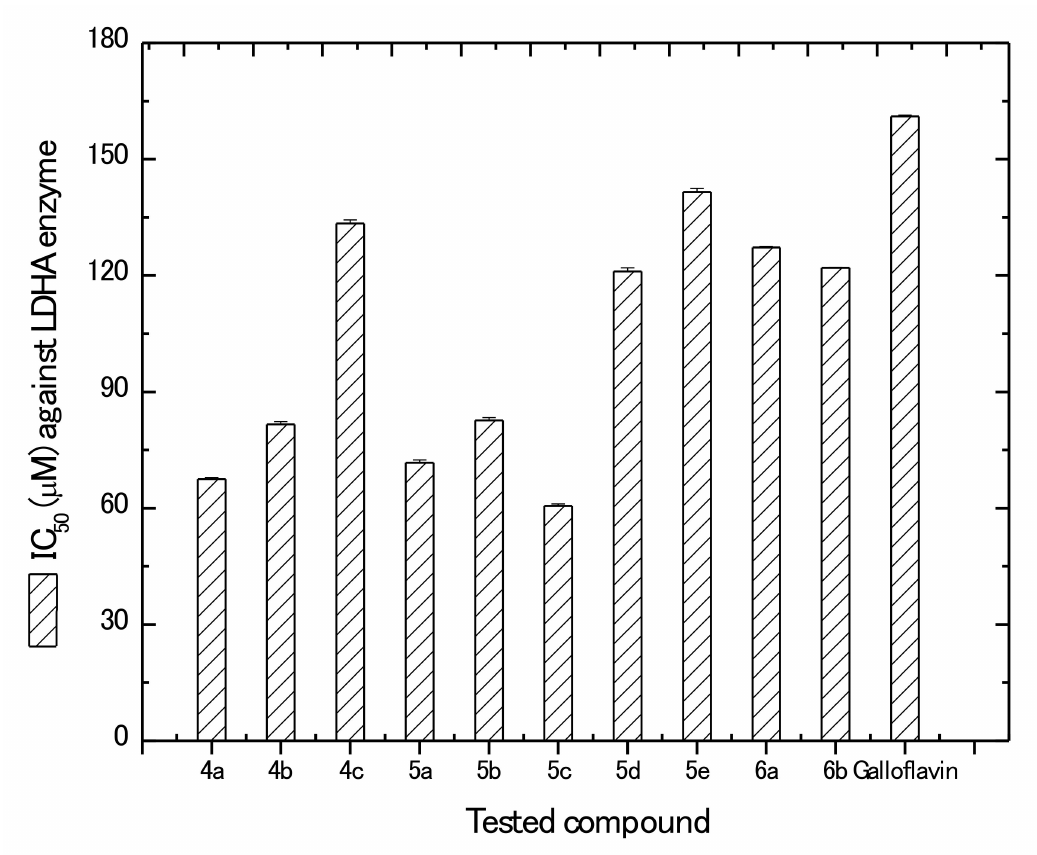
Figure 5. In vitro kinase inhibition activity of the tested compounds 4 – 6 against human lactate